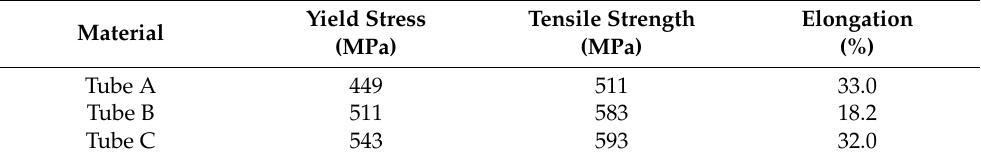
Table 1. Material properties of the steel tubes evaluated using tube-type tensile specimen (JIS 11) standardized by JIS Z 2241. standardized by JIS Z 2241.